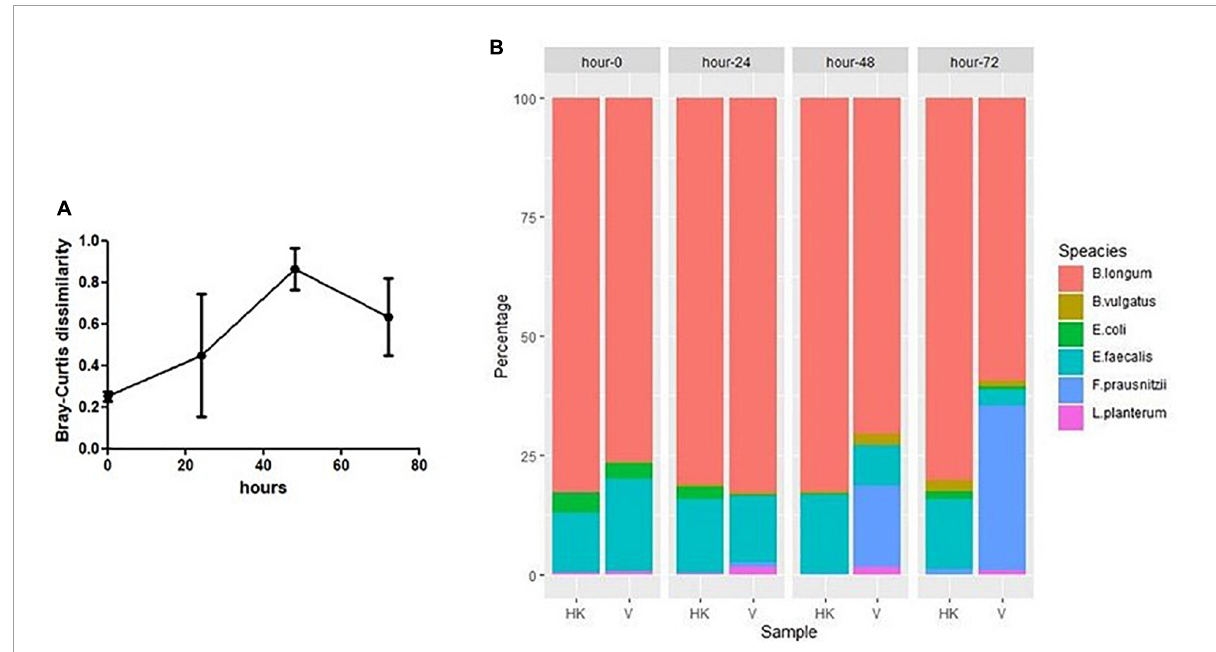
FIGURE5 (A) Dissimilarity (Bray–Curtis) between SIHUIM-6 consortium treated with heat-killed or viable phage (bars represent mean ± SD). (B) Composition of SIHUMI-6 consortium among samples taken from continuous fermentations treated with heat-killed (HK) or viable (V) phages at 0, 24, 48, and 72 h, with mean quantities (genomes copies/mL) of each species illustrated as a percentage of the total population of the community.